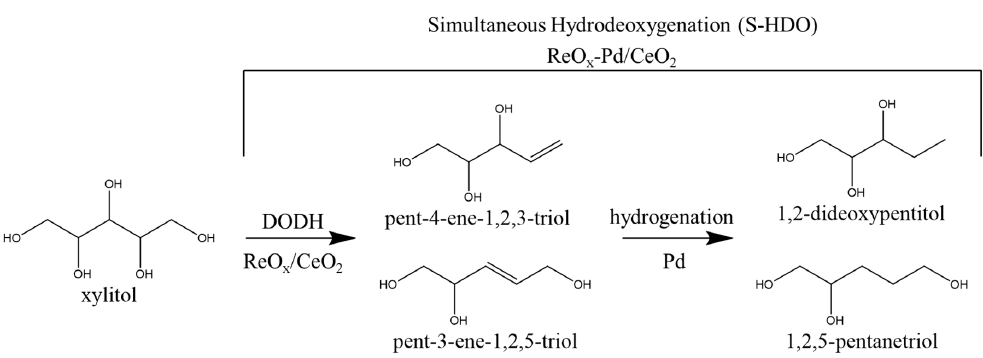
Figure 1. Reaction schematic of xylitol simultaneous hydrodeoxygenation.